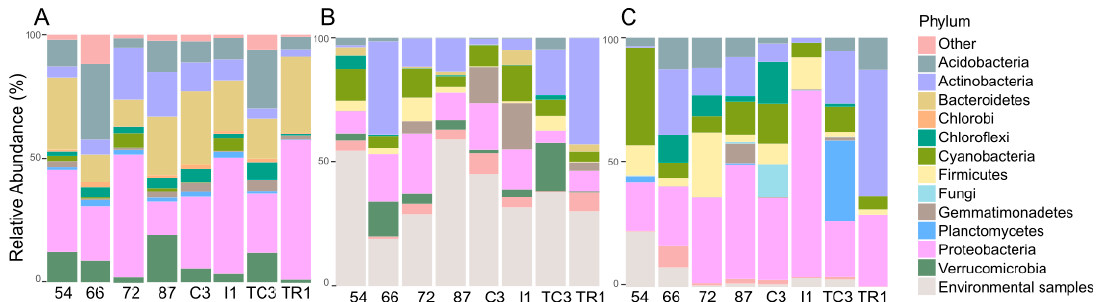
Figure 4. Relative abundance of the different phyla as revealed by 16S rRNA gene analysis ( A ) and the relative taxonomic provenience of KS ( B ) and AD ( C ) domains by identifying the best taxonomy match of the OTU biosynthetic domains using the NCBI database.